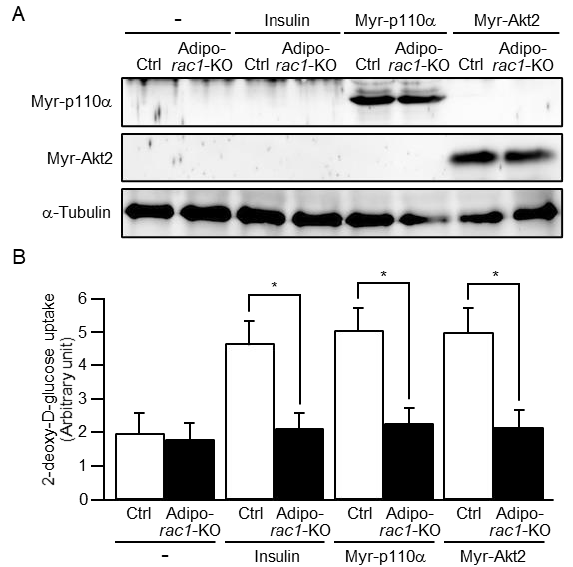
Figure 3. Inhibition of glucose uptake induced by insulin or a constitutively activated mutant of PI3K or Akt2 in white adipocytes from adipo- rac1 -KO mice. ( A ) Ectopically expressed Myr-p110α and Myr-Akt2 were detected by immunoblot analysis using an anti-hemagglutinin (HA) tag antibody. α-Tubulin (loading control) was detected by immunoblot analysis using an anti-α-tubulin antibody. ( B ) Uptake of 2-DG induced by insulin or a constitutively activated mutant of PI3K or Akt2 in white adipocytes from control (Ctrl) and adipo- rac1 -KO mice was measured. Data are shown as means ± S.E. ( n = 5). * P < 0.05.